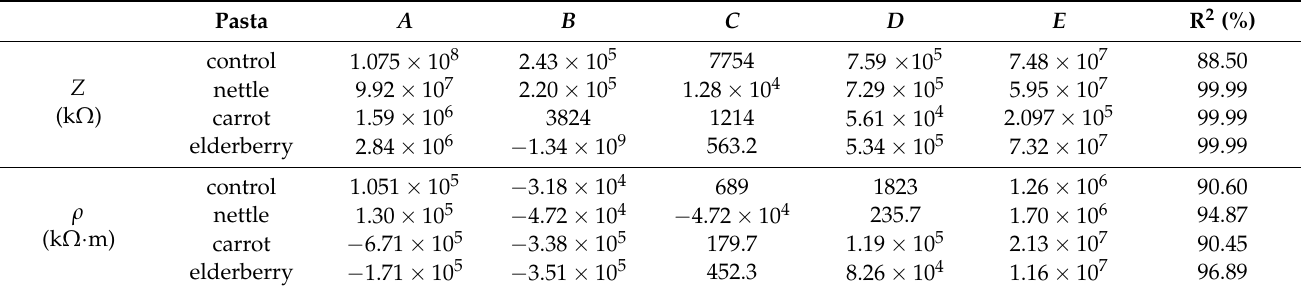
Table 6. The coefficients of transfer function (7) and coefficient of determination for all samples.